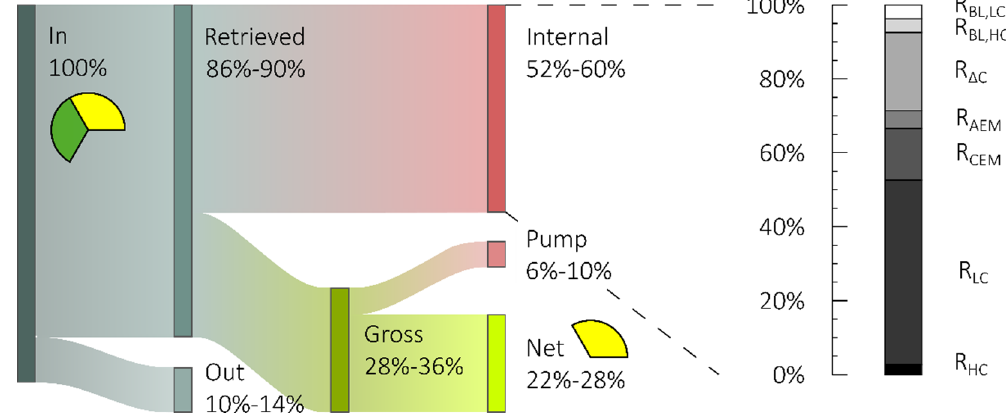
Figure 5. Global-wide energy balance of the RED plant ( left ), and relative contribution to the internal resistive losses of the 1st RED stack ( right